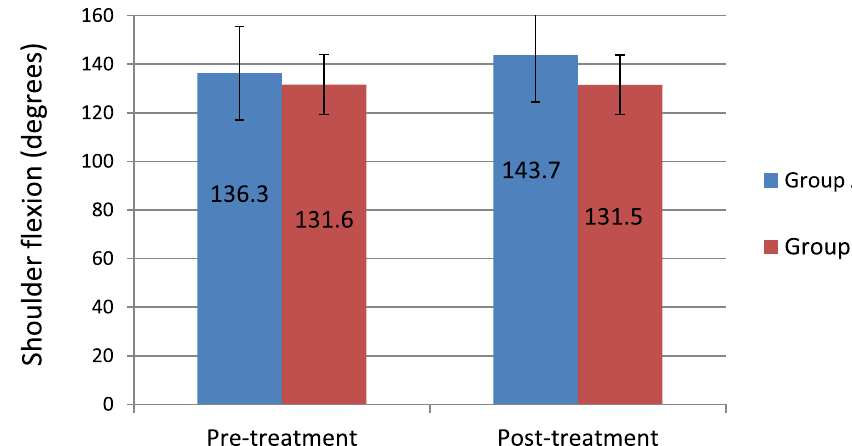
Fig. 8 Mean values of shoulder flexion pre- and post-treatment between both groups